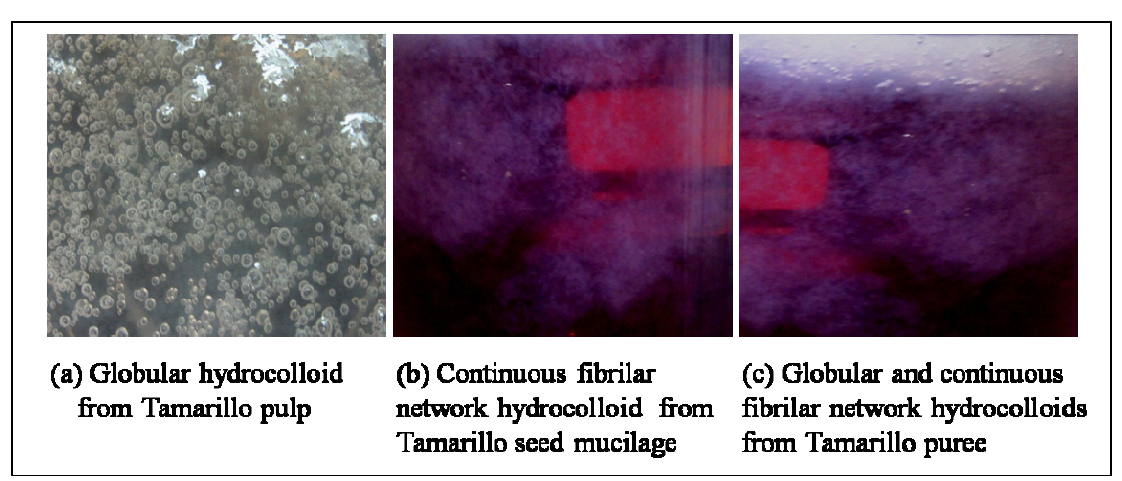
Figure 1. Visual presence of globular and continuous fibrilar network hydrocolloids (after precipitation in chilled aqueous ethanol) from tamarillo fruit